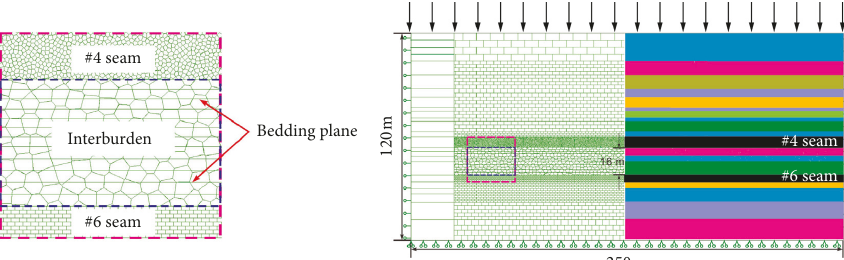
Figure 6: Model geometry and boundary conditions of the model built using the polygonal command in UDEC